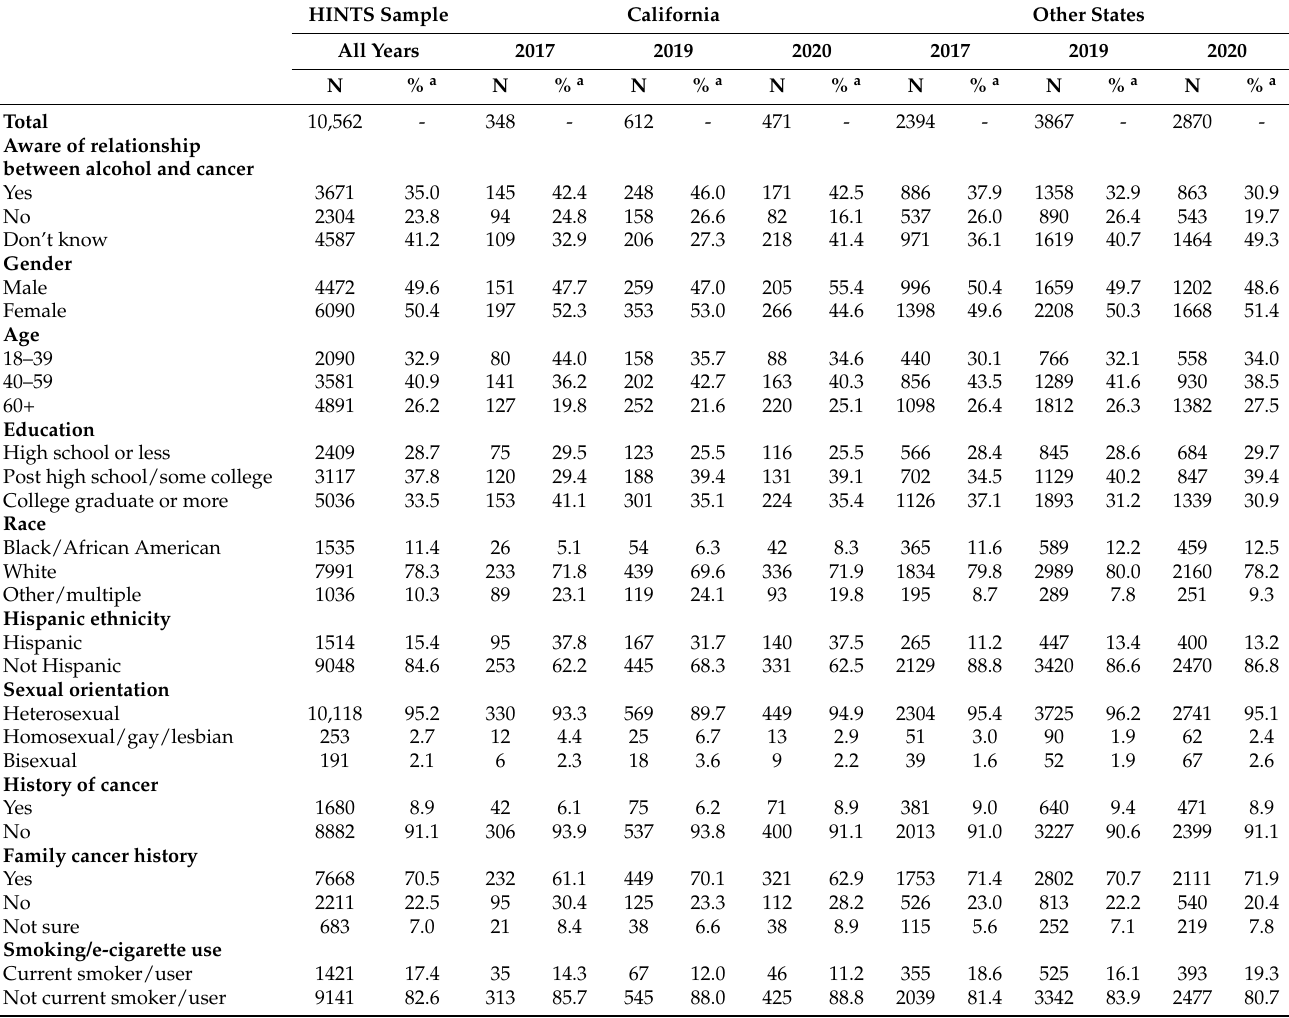
Table 1. Sample characteristics of HINTS California and remaining states samples by year.